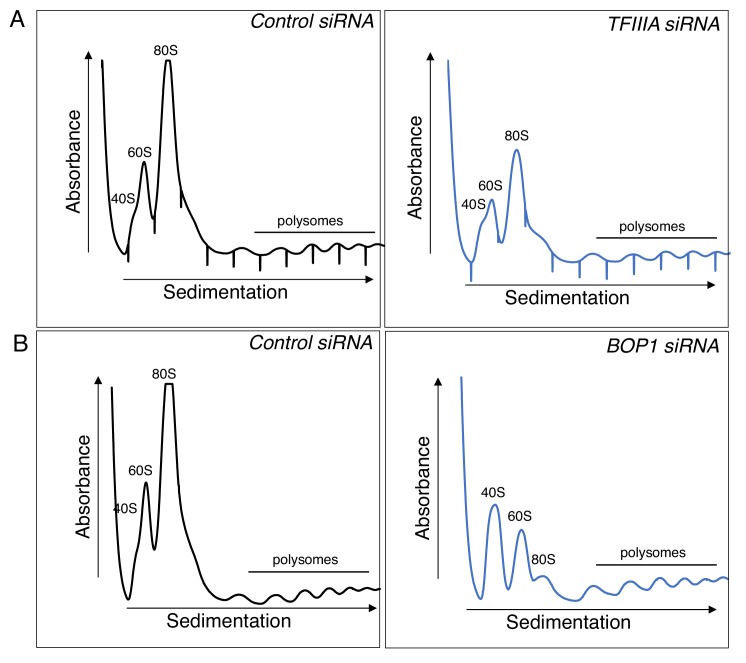
Depletion of TFIIIA or BOP1 reduce ribosome abundances In HCMV infected cells.(a) NHDFs were transfected with non-silencing (ns) control or TFIIIA siRNA and infected with HCMV (MOI = 3 PFU/cell). At two dpi, cytoplasmic lysate was fractionated over a 10–50% sucrose gradient to resolve ribosomal subunits, monosomes, and polysomes, and the absorbance at 254 nm was recorded. The top of the gradient is on the left. (b) As in (a) except ns control and BOP1 siRNA were used.